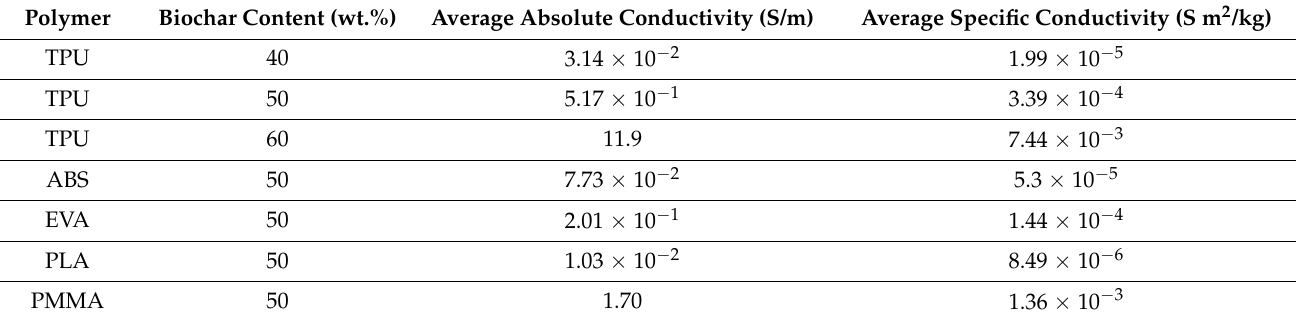
Table 1. The average values of absolute and specific conductivity measured for various polymers in biochar composite fibre. Polymer Biochar Content